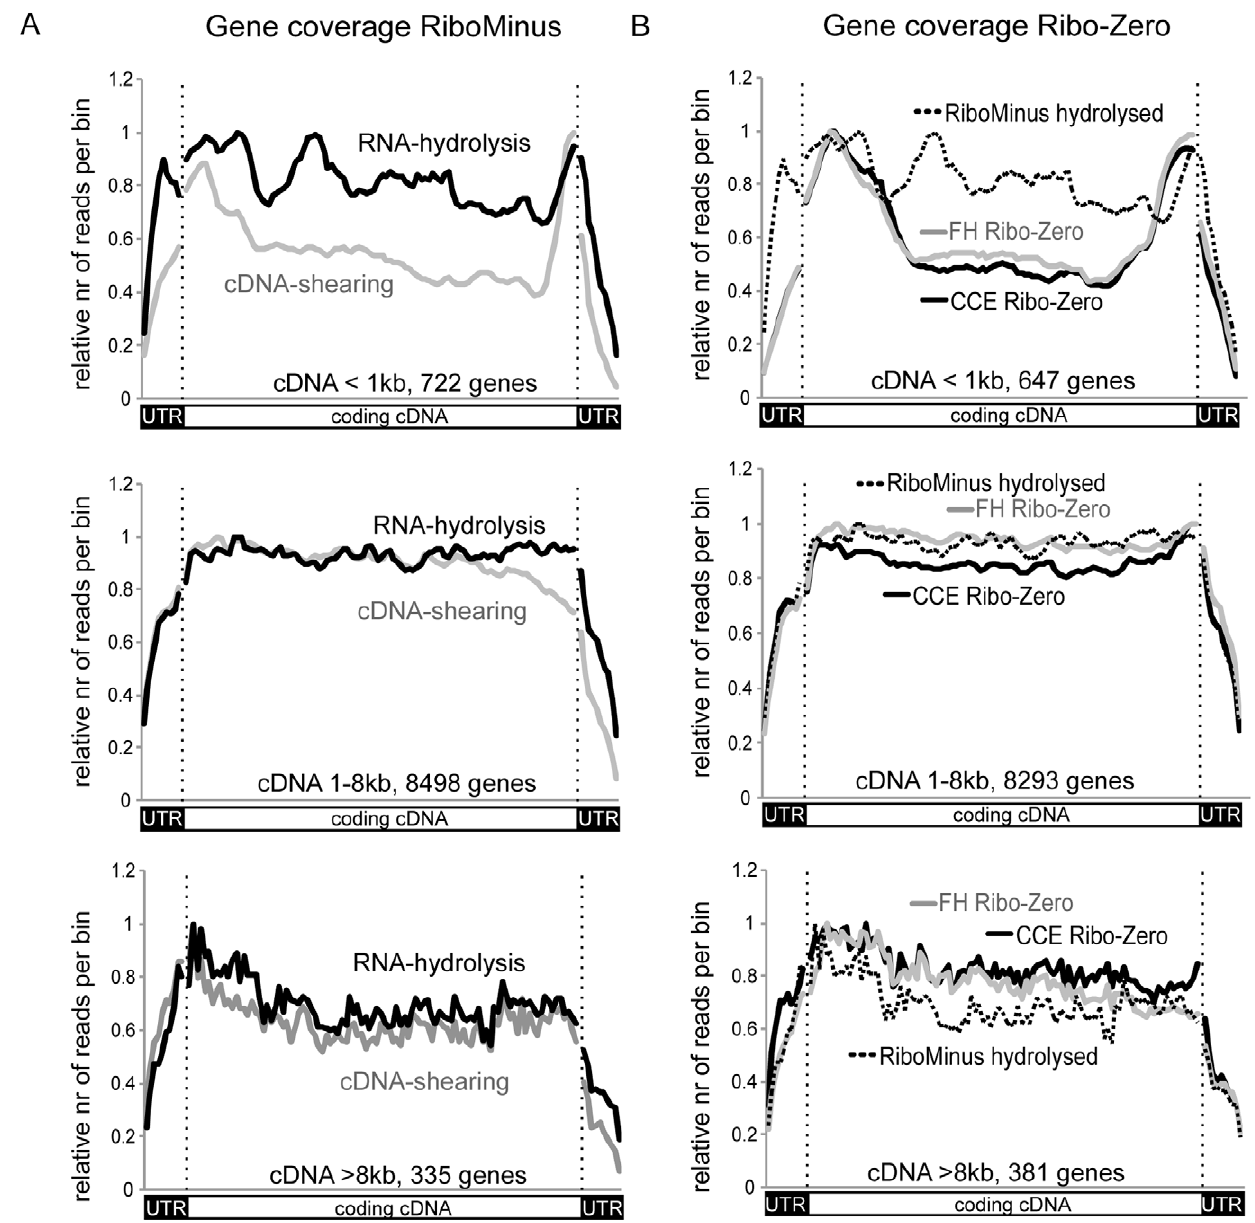
Figure 2. Tag coverage of genes differs between fragmentation methods and ribosomal RNA depletion methods. The coverage of genes with sequence tags is shown as the normalized number of tags at relative positions throughout the gene length. UTRs and coding exons were analysed separately and are plottedas 10 bins for5 9 UTRs and 3 9 UTRs and 100bins for the coding exons (separated by vertical dotted line).( A ) Comparison of the coverage in the RiboMinus dataset for the combined tags of CCE and FH from RNA-hydrolysis (black) and cDNA-shearing (grey). ( B ) Comparison of the coverage in the RNA-hydrolysis RiboMinusdataset (dotted line,same as in A)and in Ribo-Zero datasetplotted separately forCCE (black)and FH(grey). For all analyses the genes were separated into three groups according to their cDNA length (coding exons and 5 9 and 3 9 UTRs) as